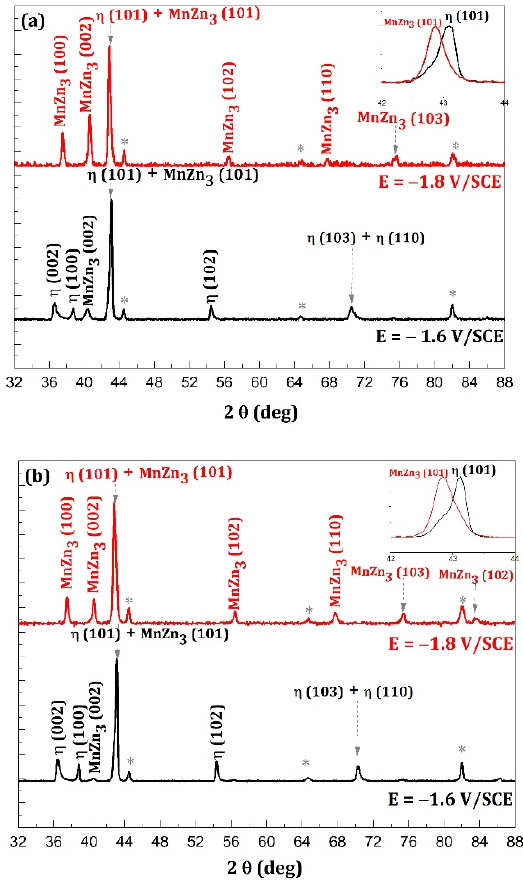
Figure 2. X-ray diffraction patterns of Zn–Mn alloy coatings electrodeposited as a function of magnetic field amplitudes: ( a ) B = 0 T, ( b ) B = 0.3 T and for two imposed potential E = − 1.6 V/SCE and E = − 1.8 V/SCE; asterisk represents substrate peaks. Phases η (JCPDS = 96-901-3473) and MnZn 3 (JCPDS = 96-153-8161).